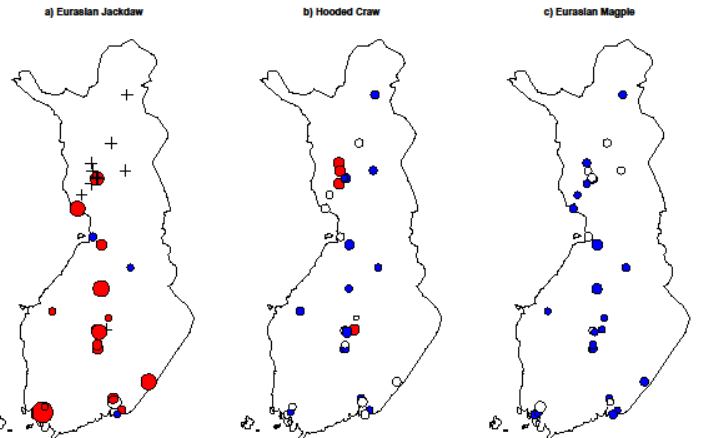
Figure 2. Population growth rates ( λ ) of the Eurasian Jackdaw ( a ), Hooded Crow ( b ) and Eurasian Magpie ( c ) populations in 31 study sites during 1991/1992–2019/2020 in Finland. The size of the dot indicates the population growth rate (the larger the dot, the greater the change) and the color of the dot indicates direction of the growth (red positive; blue negative; and open dot zero growth rates). The symbol (+) indicates a lack of observation during the four winters.